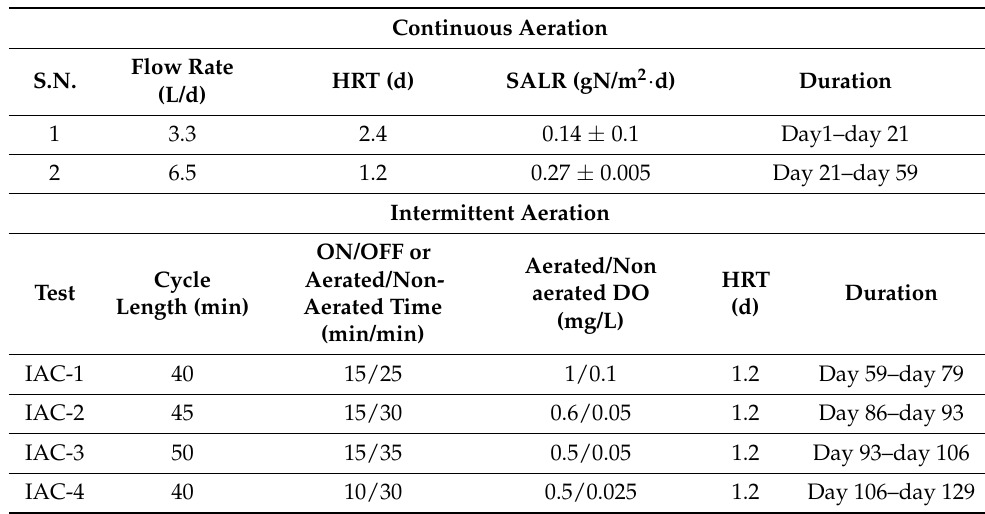
Table 1. Details of different operating